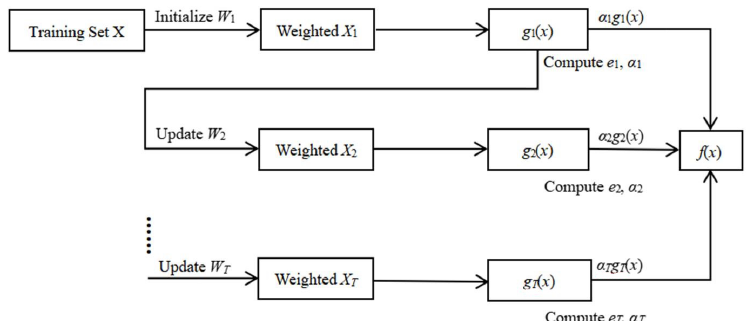
Figure 1. The principle of AdaBoost Algorithm, where X , W i , X i , e i , α i , g i ( x ), and f ( x ) represent the labeled training samples, the weight set, the weighted sample set, the classification error, the weak classifier coefficient, the weak classifier, and the final strong classifier, respectively.